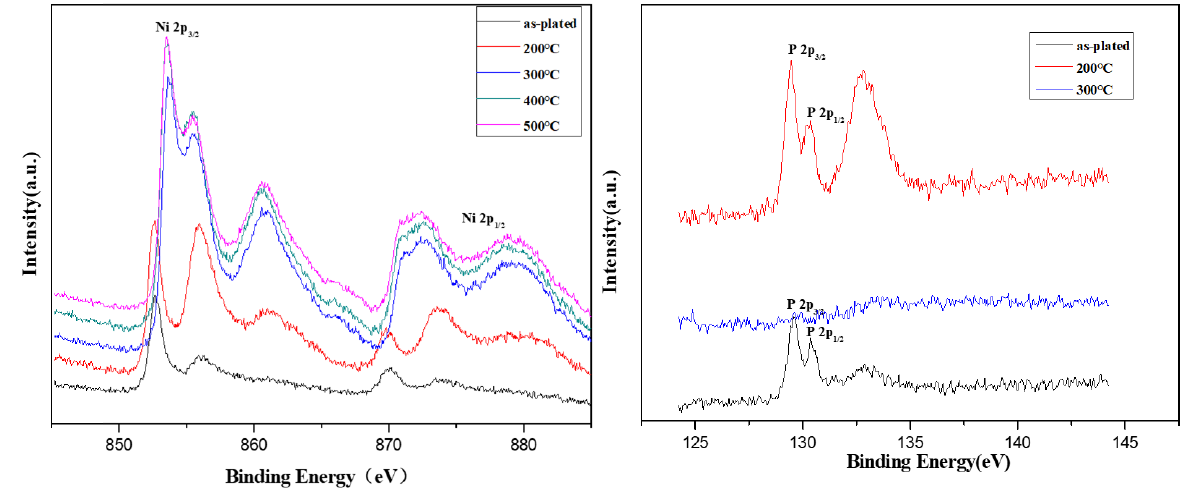
Figure 5. XPS analysis of Ni and P of the coatings with heat treatments at different temperatures.